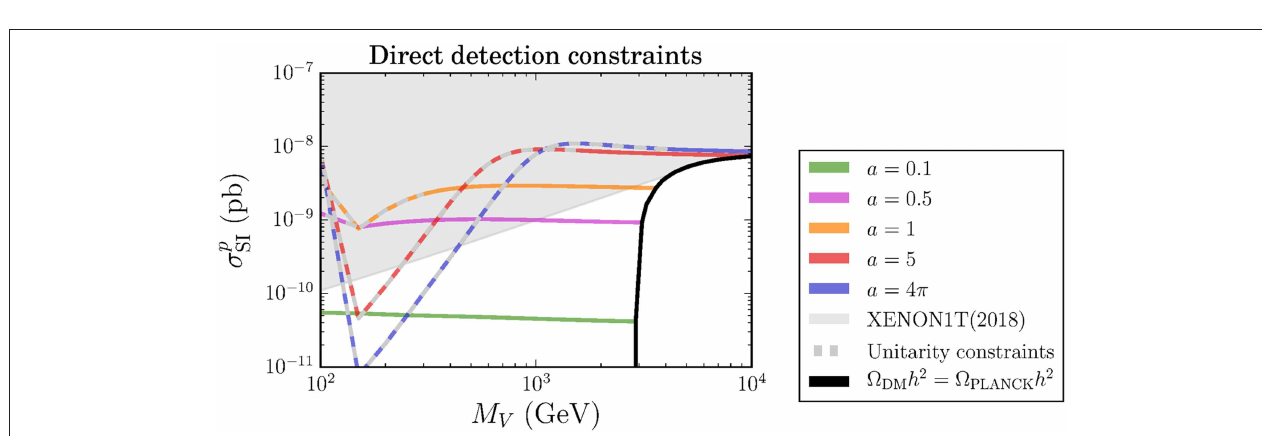
FIGURE 7 | Spin-independent cross-section for V 0 -nucleon elastic scattering as a function of M V and for representative values of a . The continuous black curve represents the elastic cross-section computed with the values of M V and a that saturate the measured DM relic density. The gray dashing highlights the parameter space where perturbative unitarity loss occurs at too low scale. See details in Belyaev et al. [36].